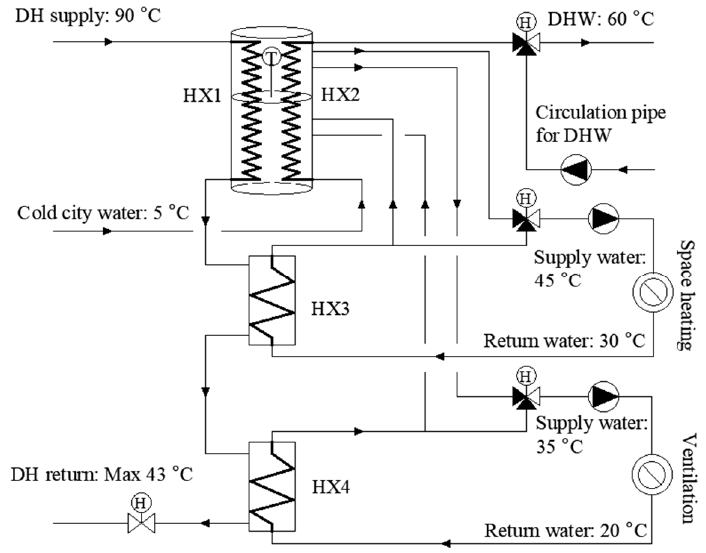
Figure 4. System connection and temperatures with short-term thermal energy storage and two return water heat exchangers in design conditions (Substation 3).